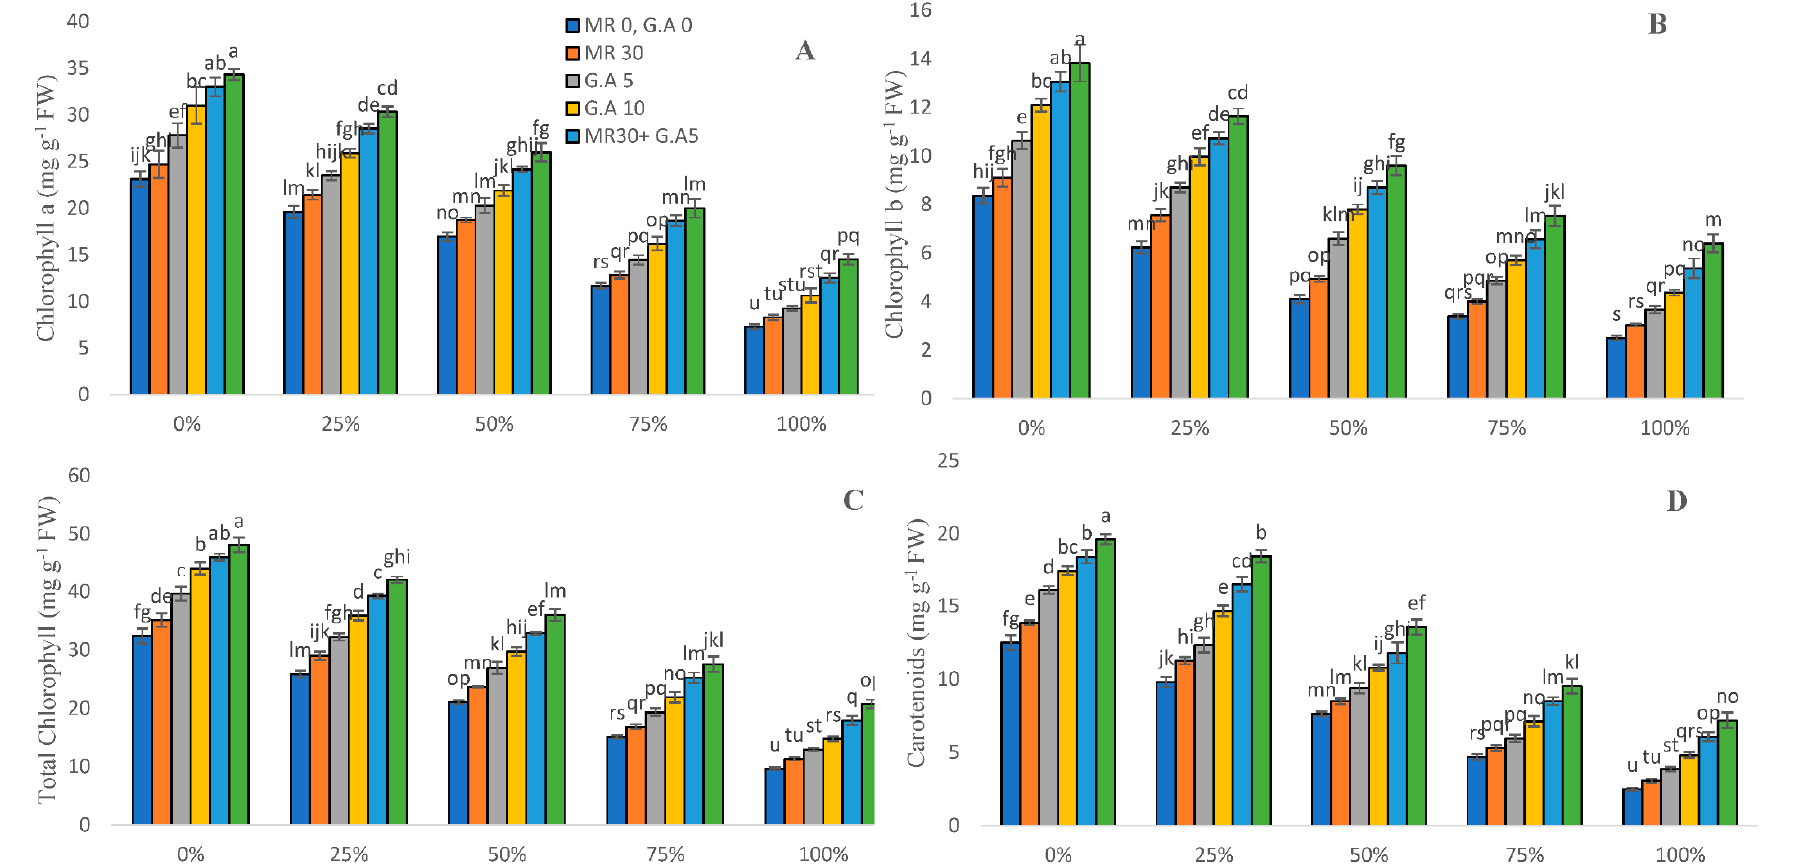
Figure 1. Surgical and textile effluent and glutamic acid effect on Chl a ( A ), Chl b ( B ), total Chl ( C ), and carotenoids ( D ) in Sorghum . Values are demonstrated as means of three replicates along with standard deviation. Different small letters indicate that values are significantly different at p < 0.05.